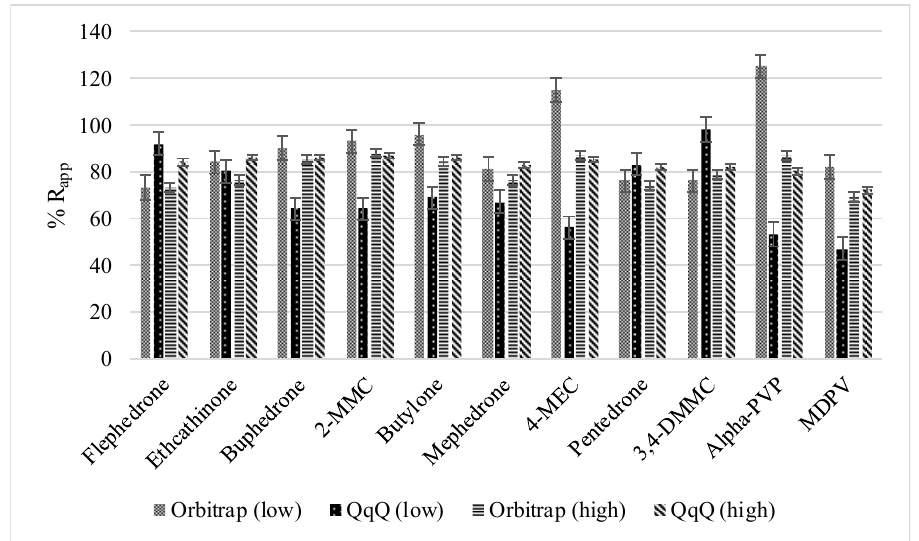
Figure 1. The percentage of apparent recovery (%R app ) at low (1 ng mL − 1 ) and high (40 ng mL − 1 ) levels of concentrations for Orbitrap and triple quadrupole (QqQ) in the analysis of synthetic cathinones in urine.